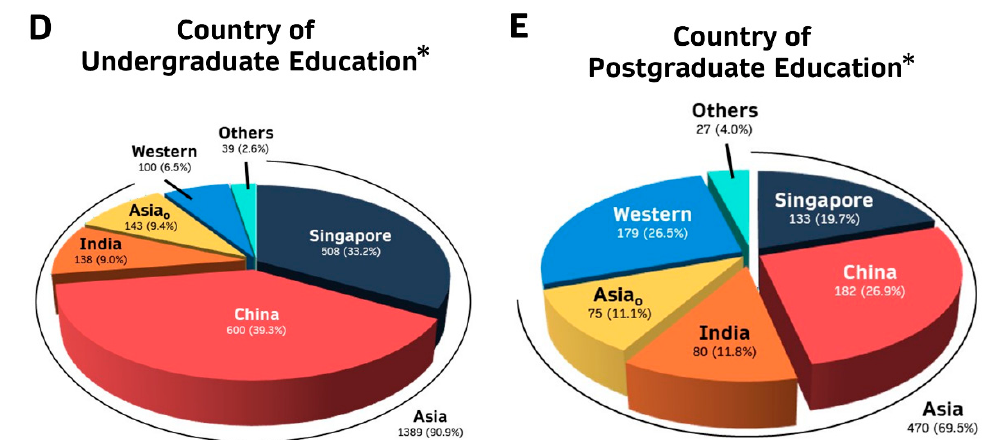
Figure 1. Proportion of respondents based on: ( A ) Field of Study (Medical Sciences: include those in the Faculties of Medicine, Dentistry and Duke-NUS Medical School); ( B ) Religion; ( C ) Citizenship (See Table S2 for the specific countries for Asia o , Western and Others); ( D ) Country of Undergraduate Education* (See Table S2 for the specific countries for Asia o , Western and Others) and ( E ) Country of Postgraduate Education* (See Table S2 for the specific countries for Asia o , Western and Others). *For students who studied in universities from more than one country, all the different countries are included.